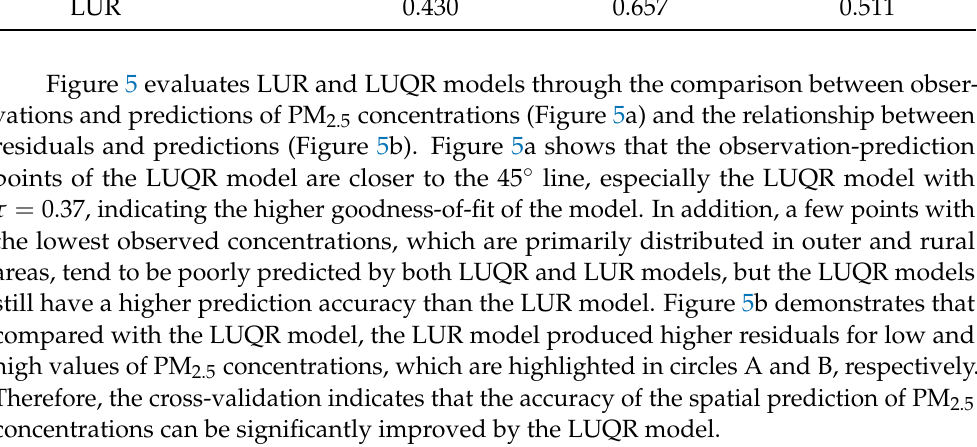
Table 3. Model evaluation using a leave-one-out cross validation. The unit of RMSE and MAE is µ g/m 3 . Model R 2 RMSE LUQR ( τ = 0.37)